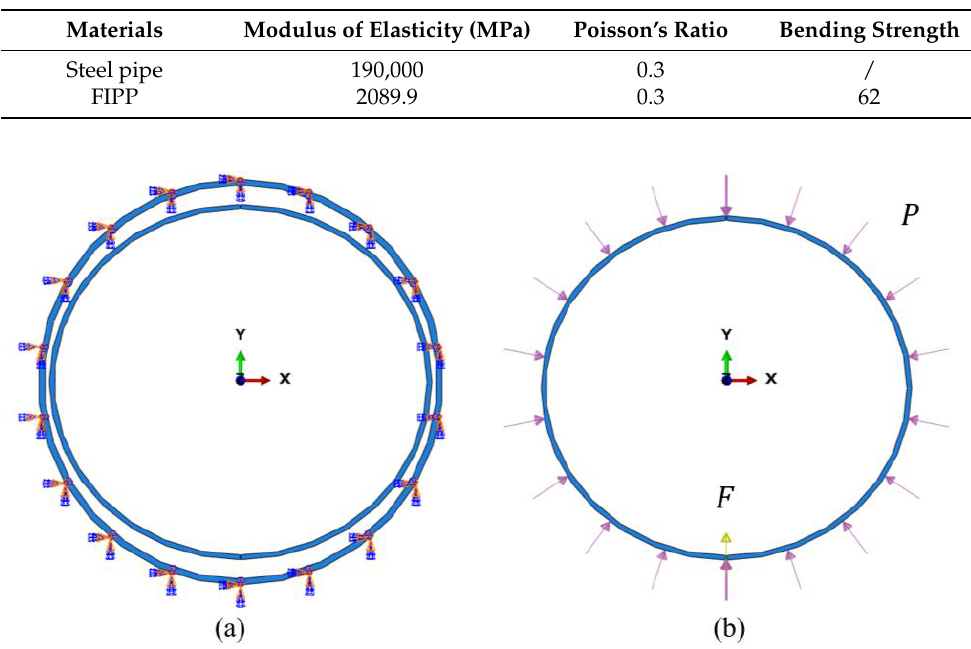
Table 3. Mechanical properties of FIPP liner and host pipe.